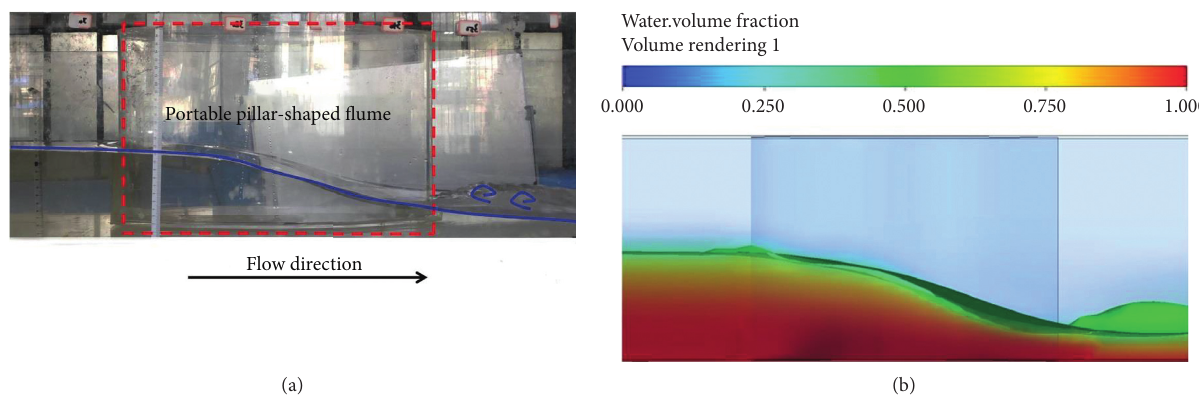
Figure 5: Comparison of the simulated and experimental flow patterns: (a) profile of the measured flow pattern; (b) profile of the simulated flow pattern.